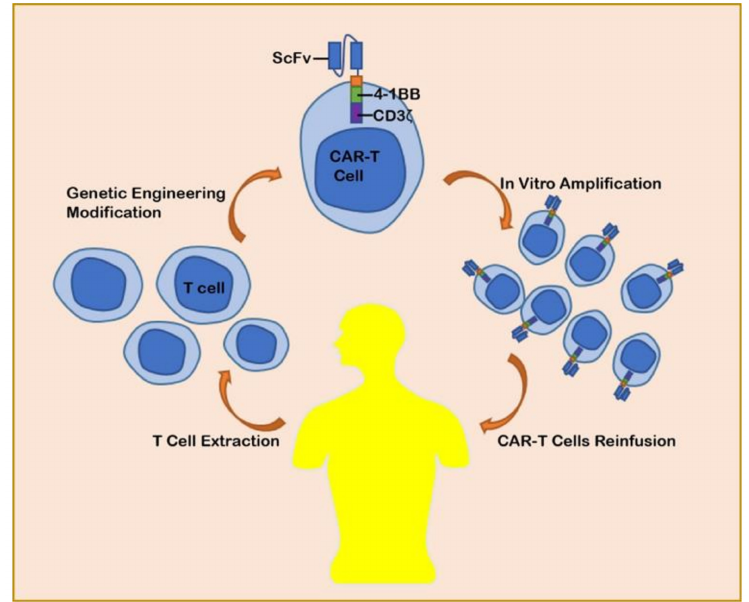
Figure 1. Flowchart of CAR-T cells